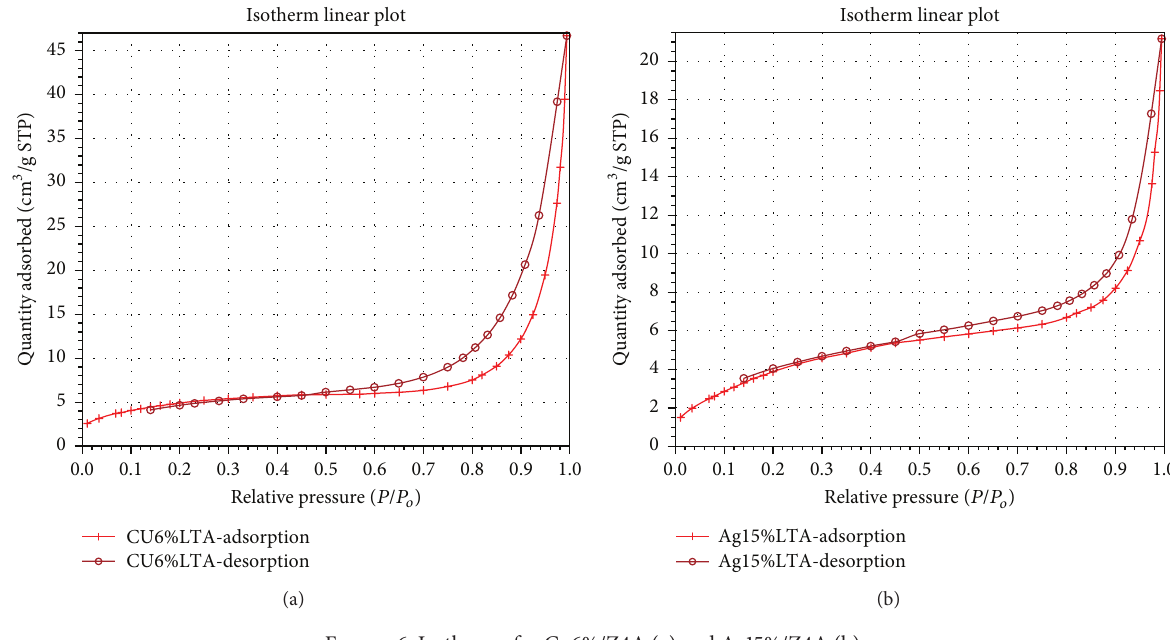
Figure 6: Isotherms for Cu6%/Z4A (a) and Ag15%/Z4A